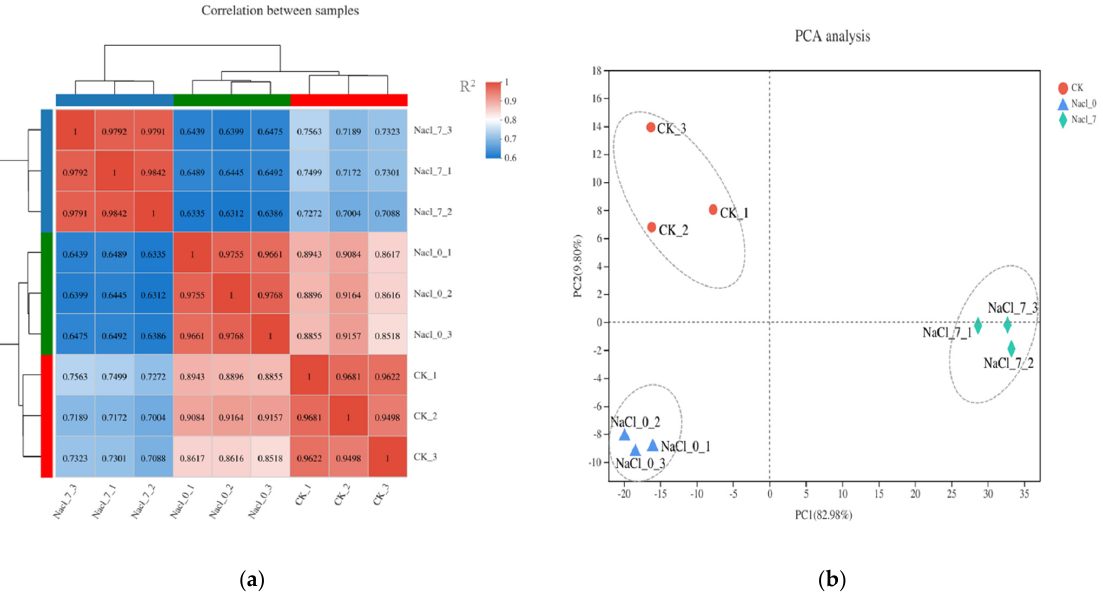
Figure 5. Correlation analysis between samples ( a ) and principal component analysis (PCA) of samples ( b ) of V. brasiliensis under different NaCl concentrations cultured. ( a ) Both the abscissa and the ordinate indicated the names of samples under different processing conditions, and each sample was set with three biological replicates. CK represent 2% NaCl concentration and as control; Nacl_0 represent 0% NaCl concentration; Nacl_7 represent 7% NaCl concentration. The shade of the square in the figure represents the correlation coefficient R 2 . Red indicates positive correlation, and blue indicates lower the correlation; ( b ) the three dots with the same color represent three biological replicates in each group.